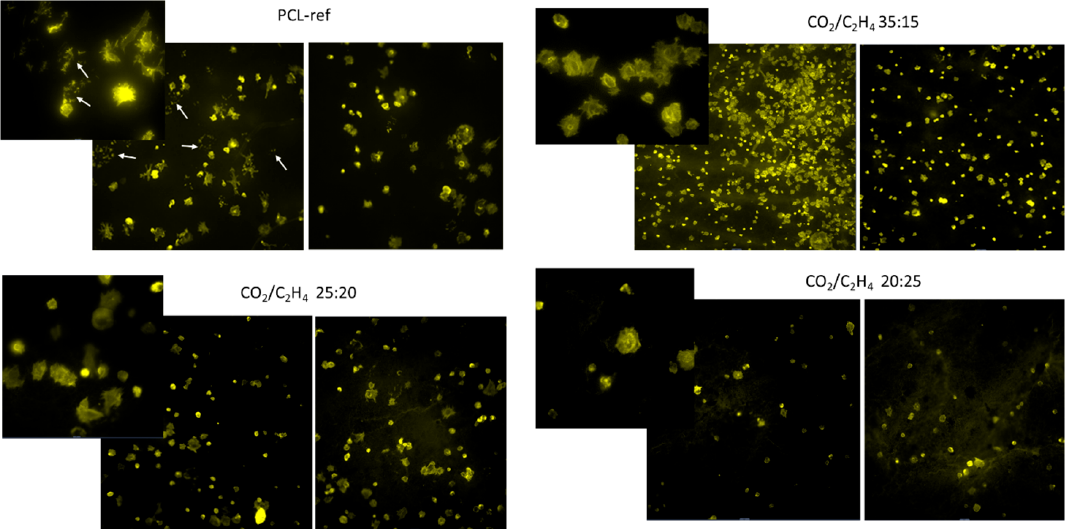
Figure 10. Representative fluorescent photographs of cells seeded on nanofibers after 2 h. Actin filaments of the cytoskeleton were stained by Phalloidin. White arrows indicate apoptotic cells. Images are shown at ×20 and ×60 magnification.